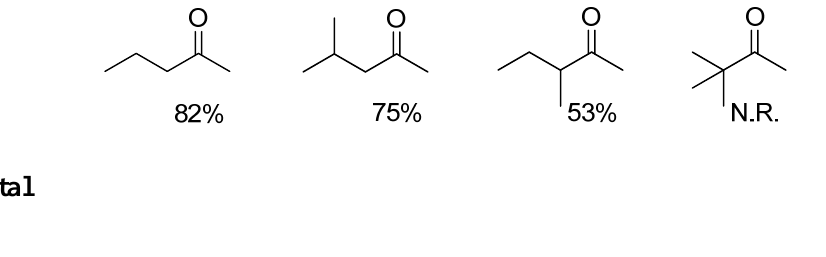
Figure 3. Conversions observed in the DARA with 1a (X = 3-H ) (1%) at 5 bar H 35 ºC in 8